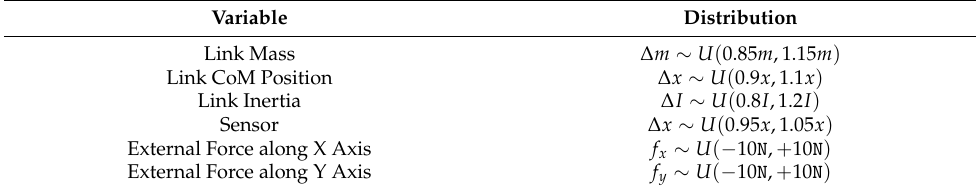
Table A4. Randomization